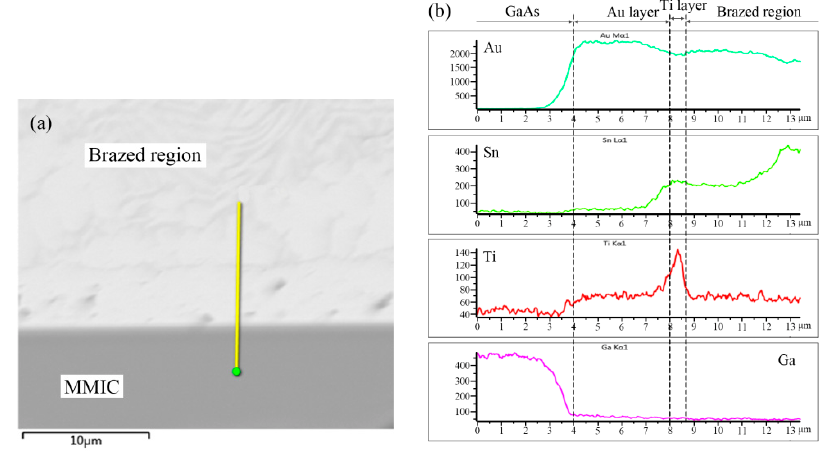
Figure 7. EDS analysis of the Au/Ti/Au|Au-Sn eutectic joint: ( a ) measured position and ( b ) elemental